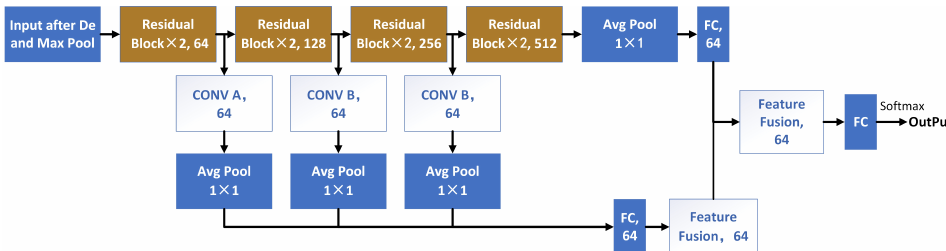
Figure 7. Convolution kernel